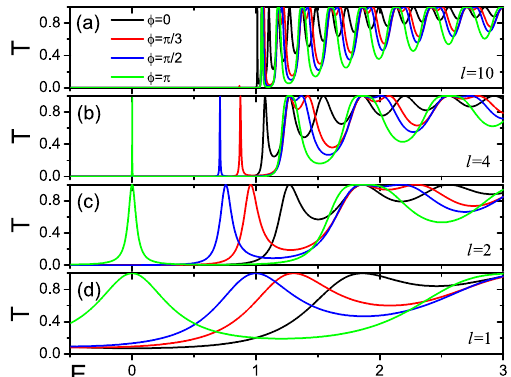
Figure 2. Transmission function for two magnetic domains of equal size ( l = L / L 0 = 10, 4, 2, 1), with the perpendicular component of the magnetic moments oriented with a relative tilt φ . Energies ( E expressed in units of ε